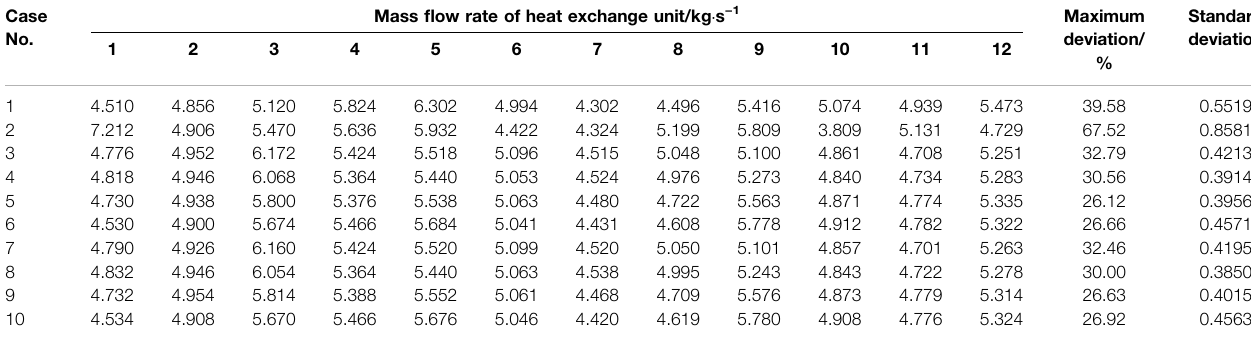
TABLE 4 | Numerical results of inter-unit fl ow rate distribution of fl ow homogenizers with UASHs. Case